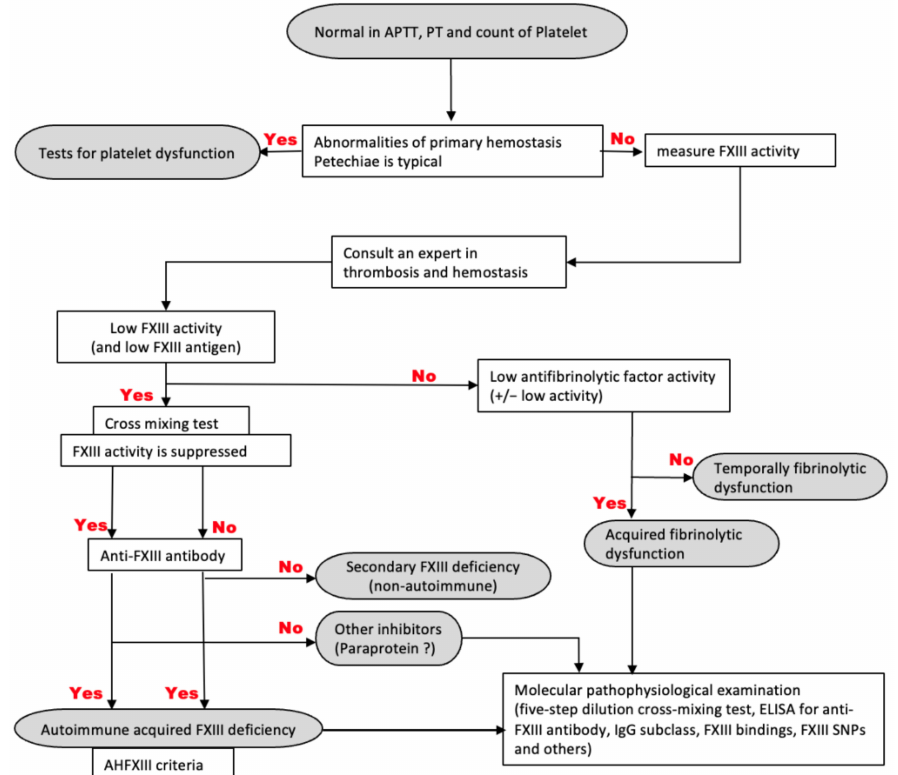
Figure 1. Flowchart for diagnosing autoimmune factor XIII deficiency with bleeding symptoms used in Japan. FXIII: factor XIII; ELISA: enzyme-linked immunosorbent assay; IgG: immunoglobulin G; SNPs: single nucleotide